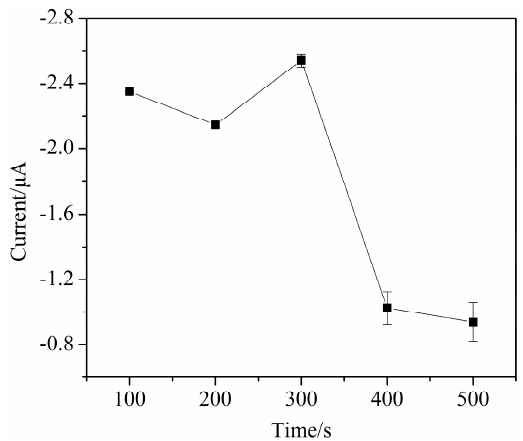
Figure 9. The effect of AuNPs deposition time on the current response of Cr (VI) detection (pulse size = 25 mV, frequency = 25 Hz, step size = 5 mV, 0.1 mol/L sodium acetate buffer, pH 6).